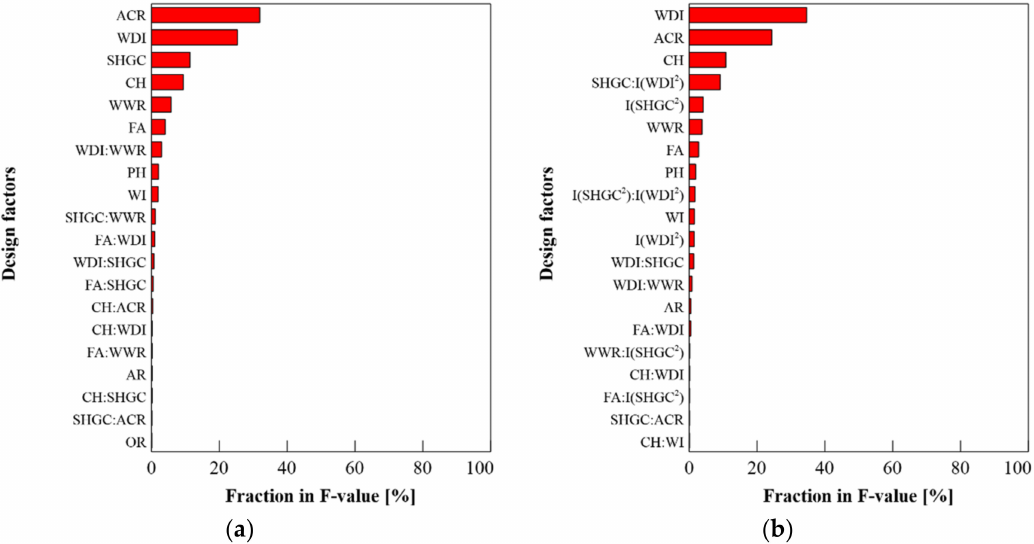
Figure 7. Factor importance analysis for heating load of the meta-models using: ( a ) FFD; ( b ) LHS considering